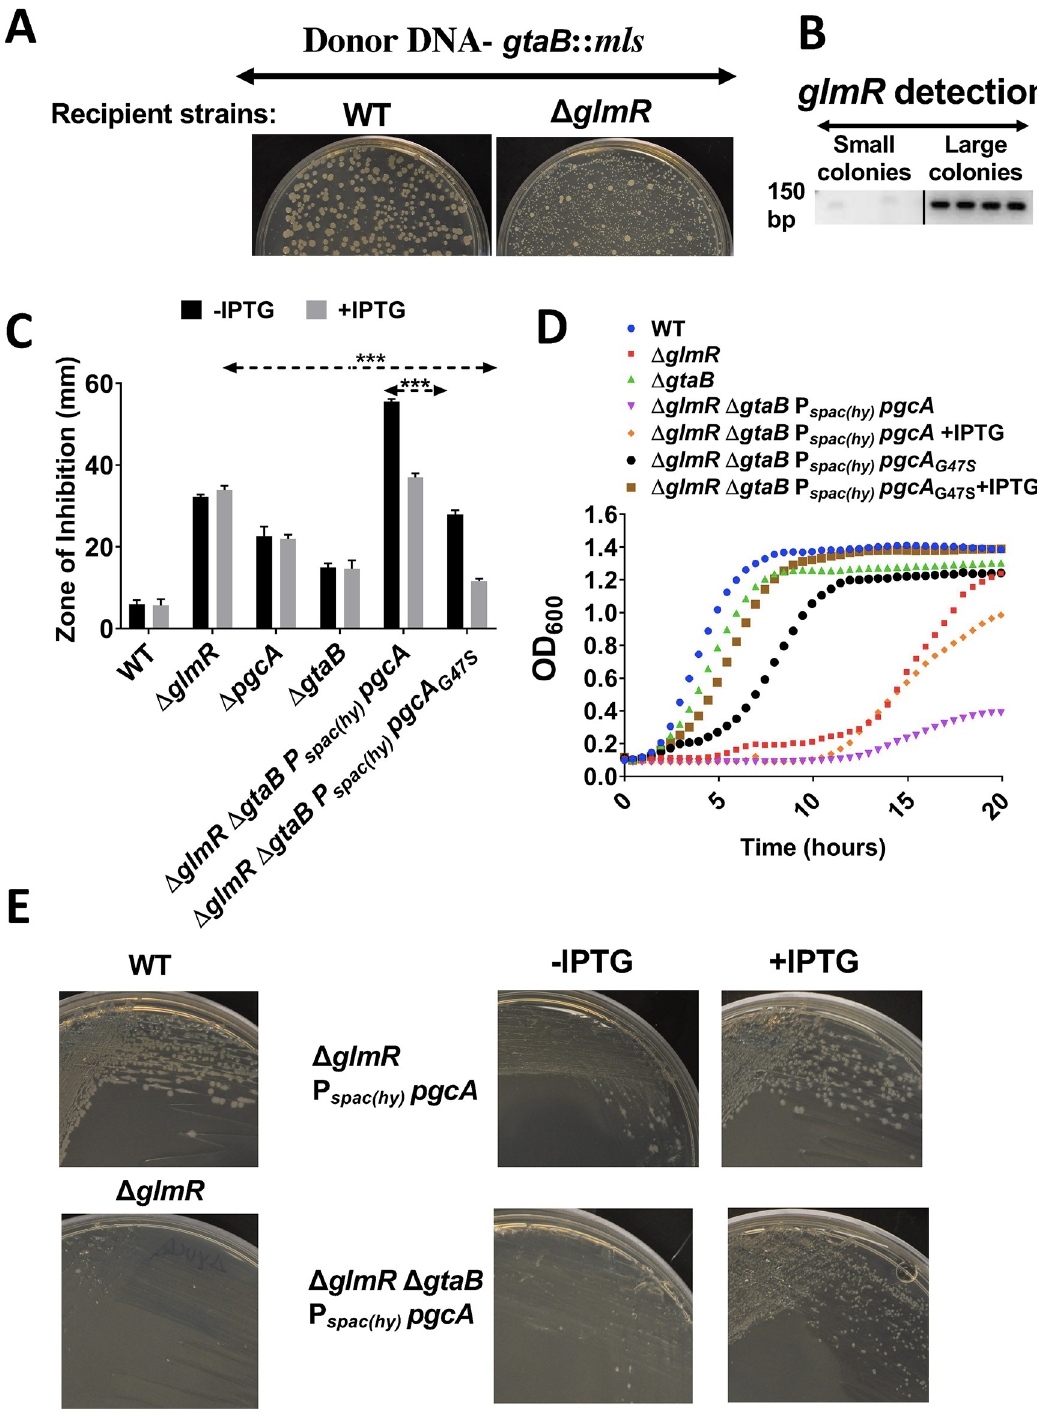
Fig 4. pgcA G47S suppresses a glmR deletion mutation independent of UDP-Glc biosynthesis. (A) Representative pictures (N > 3) showing LB with 20 mM MgSO 4 plates for WT and Δ glmR transformation with gtaB :: mls chromosomal DNA, (B) A representative agarose gel (N > 3) electrophoresis image showing PCR amplification of Δ glmR with internal check primers. (C) CEF susceptibility assay done with 6 μ g antibiotic and (D) representative growth curve on MH medium. Standard deviation (error bars) is based on at least three biological replicates. Three asterisks represent statistical significance with P < 0.001 with Tukey test. (E) Growth study on MH agar plates. The pictures were taken after overnight incubation at 37 0 C. 1 mM IPTG was added when required in all